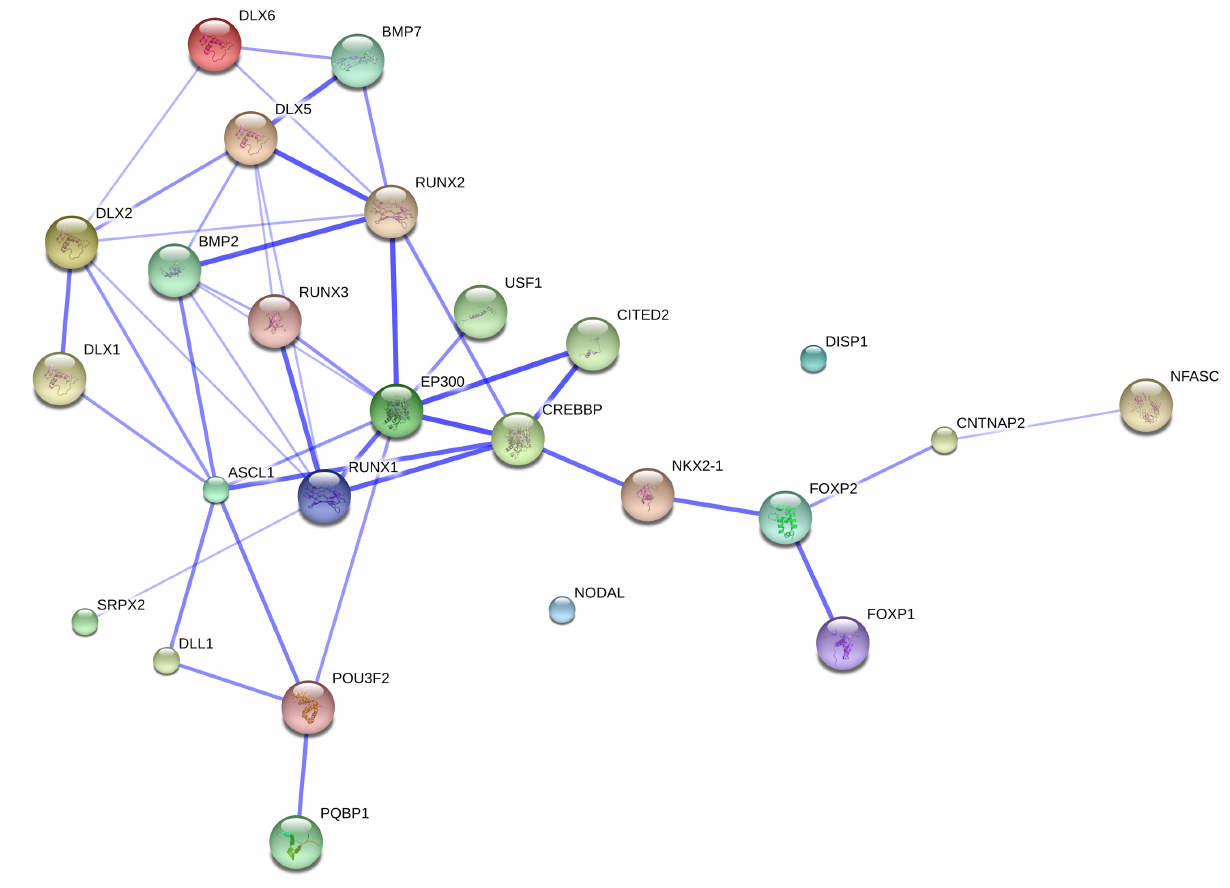
FIGURE 2 | The FOXP2 suite and the genes related to globularity. The network was generated by String 9.1 with the proteins discussed in Section “ FOXP2 and Partners” plus the gene set related to globularity as advanced in Boeckx and Benítez-Burraco (2014).The medium confidence value was 0.0400.The caveats noted for Figure 1